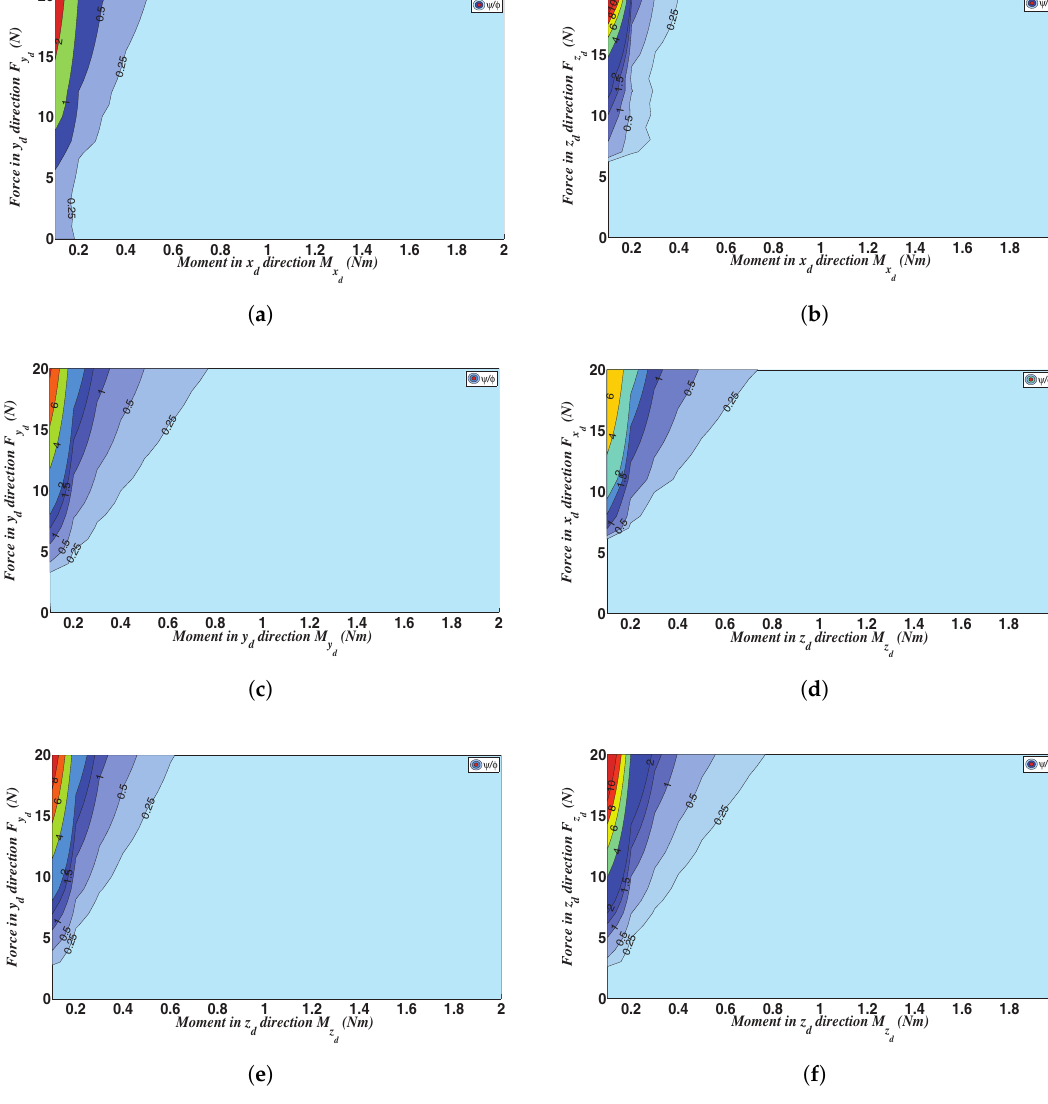
, and force, F y ; ( b ) moment, d d , and force, F x ; ( e ) moment, M z d d